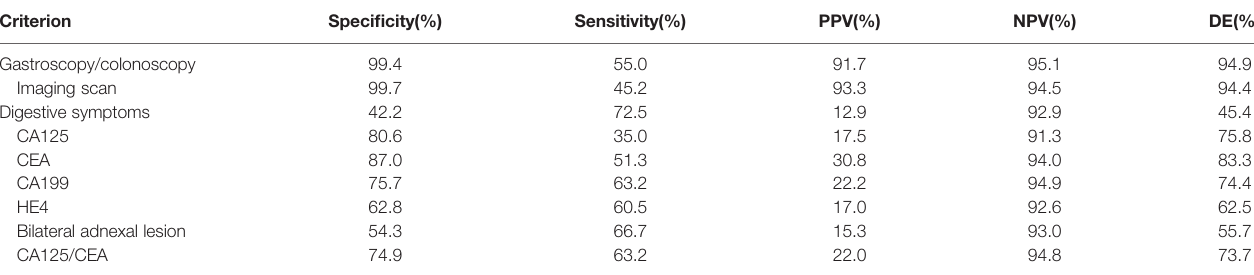
TABLE 2 | The diagnostic value of ovarian metastatic carcinoma by different criteria. Criterion